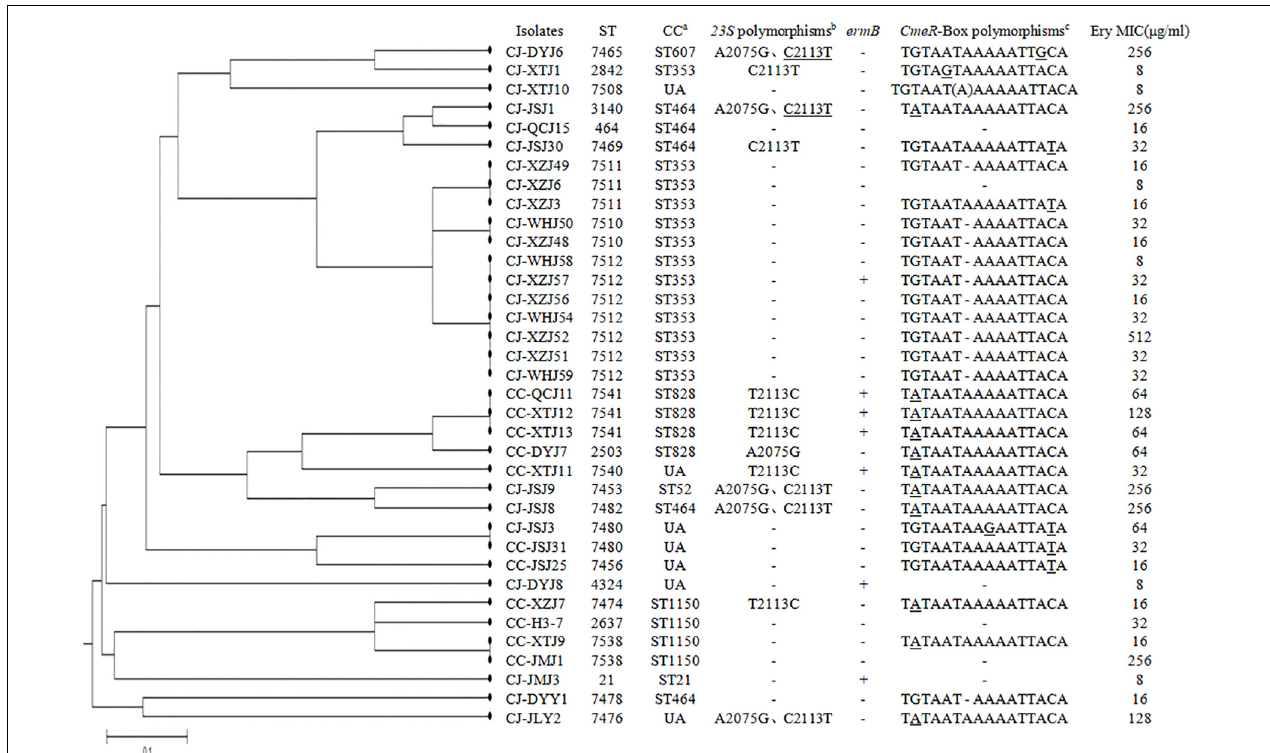
FIGURE 1 | Dendrogram of multilocus sequence typing (MLST) profiles among the 36 erythromycin-resistant Campylobacter isolates. Corresponding minimum inhibitory concentrations (MICs) of erythromycin, erythromycin-resistant genes, mutations found, and the CmeR-Box sequence are listed for each isolate. a UA means unallocated in campylobacters. b The underline indicates that two of the three copies were mutated. c Underline means point substitution, “(A)” means point insertion, “–” means point